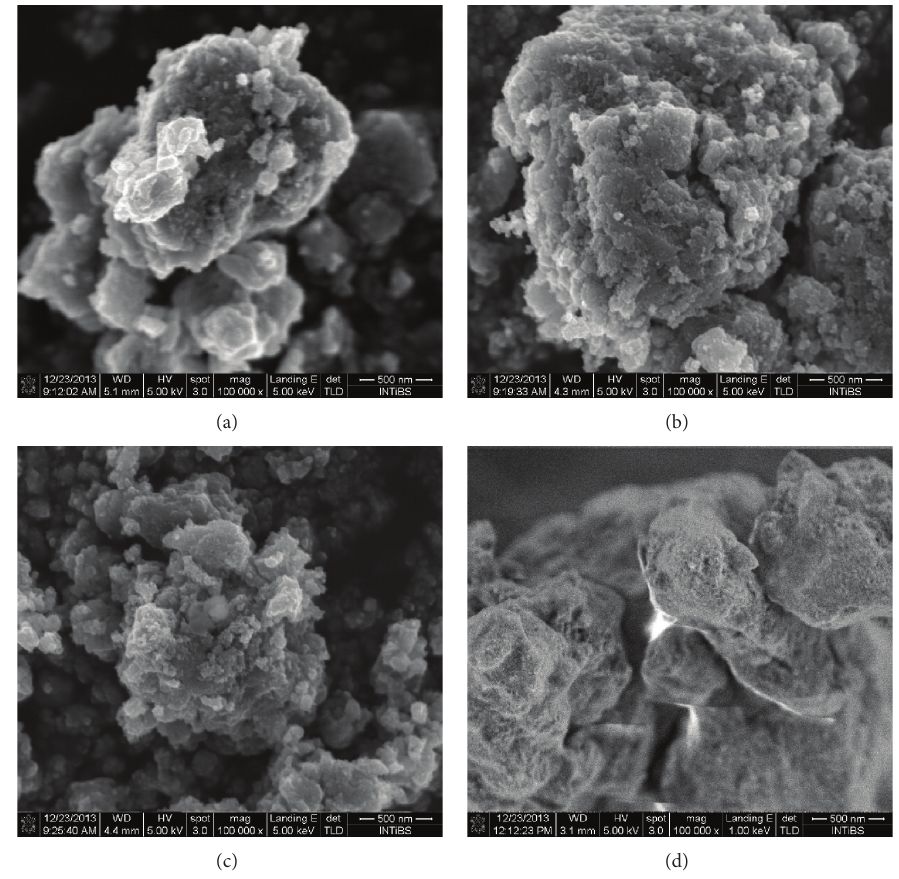
Figure 5: SEM images of (a) TiO 2 , (b) TiO 2 :Nd (1 at. %), (c) TiO 2 :Nd (3 at. %), and (d) TiO 2 :Nd (6 at. %) nanoparticles.